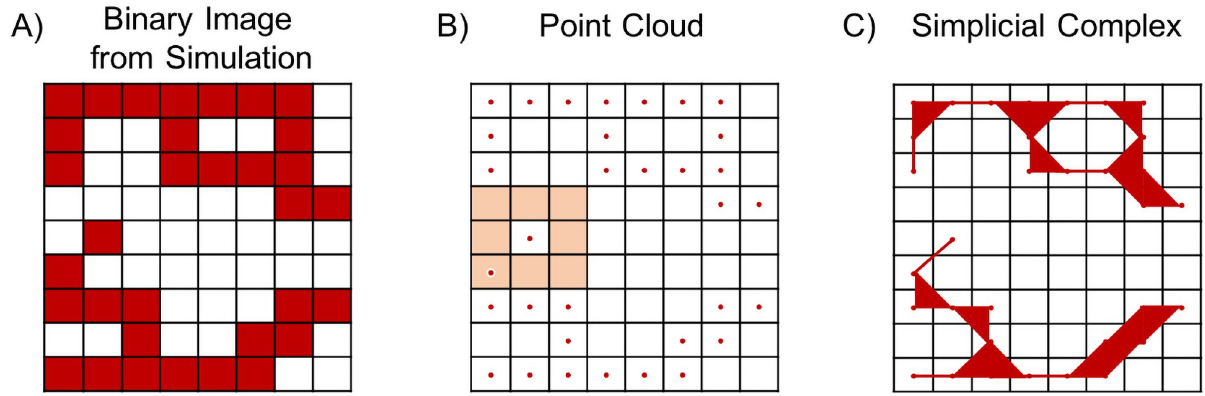
Fig 4. Converting a binary image into a simplicial complex. A) Schematic binary image. B) Point cloud for all nonzero pixels in the binary image. The Moore neighborhood of one nonzero pixel is highlighted in salmon. C) A simplicial complex constructed from the point cloud in panel B.